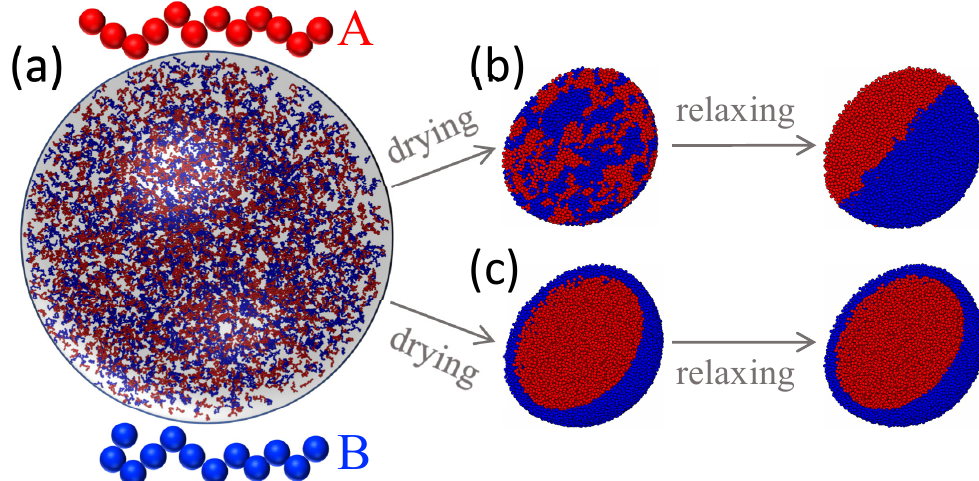
Figure 5. ( a ) A solution droplet of a polymer blend prior to drying. Depending on the interaction with the receding liquid-vapor interface, polymeric particle with different morphologies are obtained after drying: ( b ) A Janus particle is produced with θ = 0 for both polymer A (red) and B (blue) after drying for 5 × 10 3 τ followed by relaxation for 2 × 10 5 τ ; ( c ) A core-shell particle is produced with θ = 0 for polymer A (red) while θ = π /2 for polymer B (blue) after drying for 5 × 10 3 τ followed by relaxation for 5 × 10 4 τ . For clarity, the droplets after drying and relaxation are sliced through the center to show the